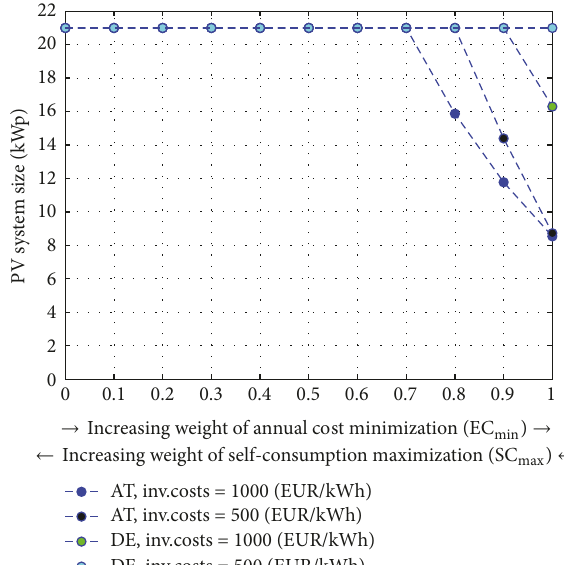
Figure 13: Comparison of optimally dimensioned PV peak capacity for different case